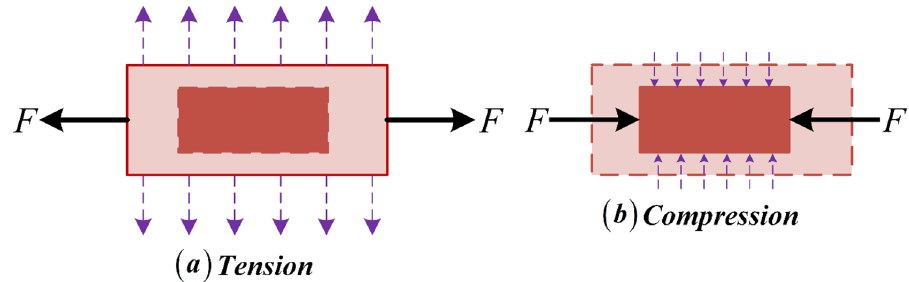
Figure 1. Auxetic material in ( a ) Tension and ( b ) Compression